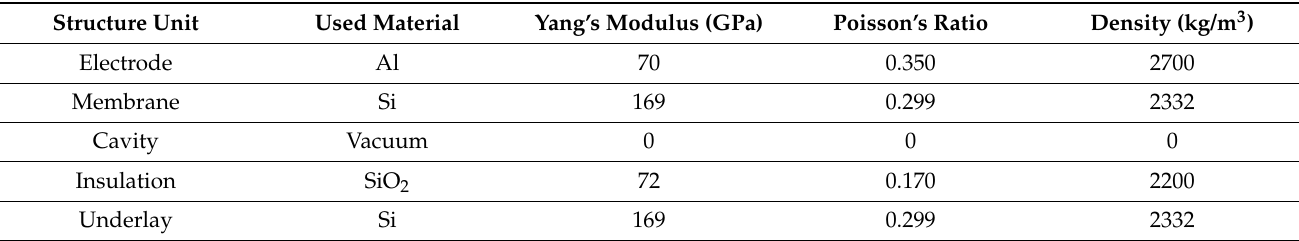
Table 1. CMUT cell structure parameters.